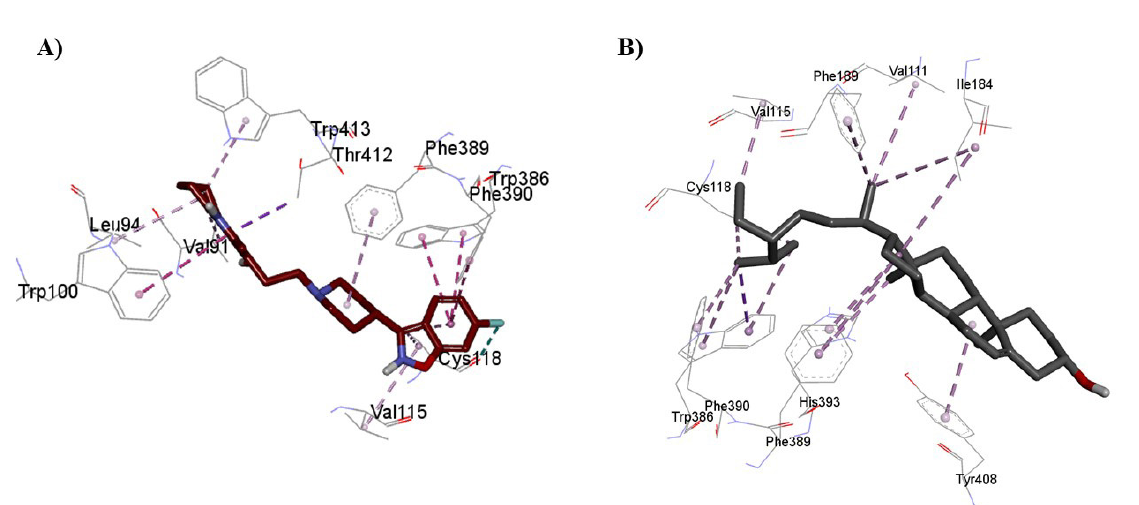
FIGURE 1 - The binding interactions between the ligands and D2 receprtor. A) Risperidone B) β-sitosterol. Halogen interaction is presented by cyan, Pi-alkyl by pink, Pi-sigma by violet and Pi-Pi stacking interactions by magenta dotted